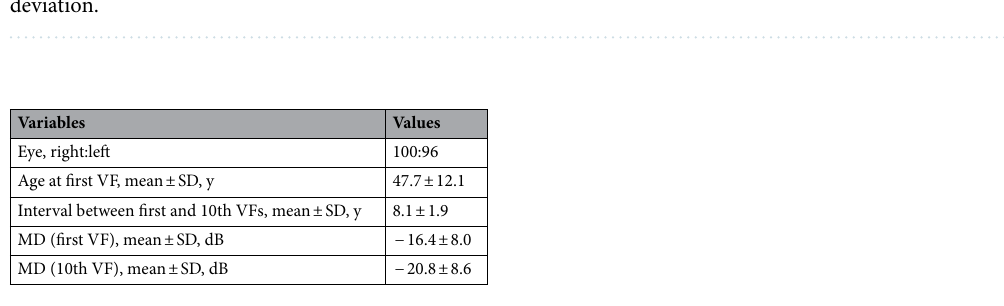
Table 2. Demographic data of the patients for the validation. VF visual field, SD standard deviation, MD mean deviation.